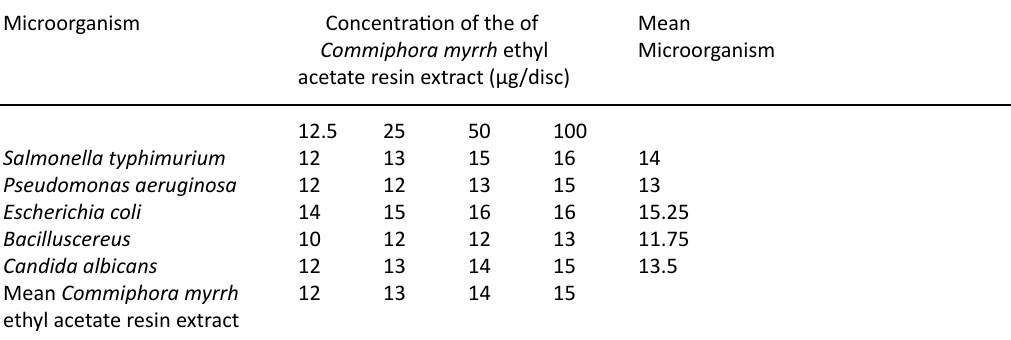
Table 9. Inhibition zone (in mm) for different concentrations of Commiphora myrrh petroleum ether resin extract Microorganism Concentration of the of Mean